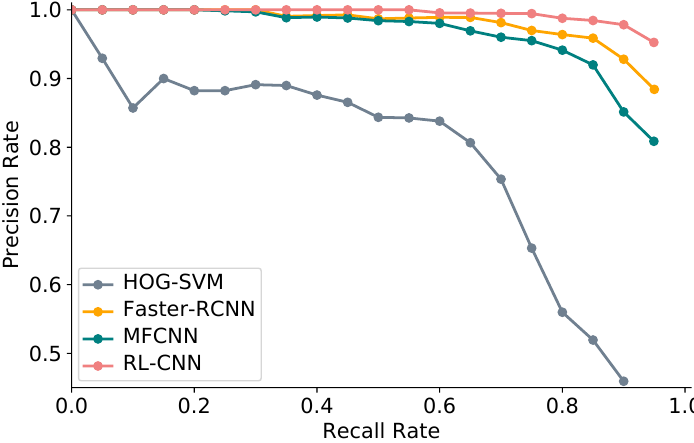
Figure 10. Precision–Recall Curves of HOG-SVM, MFCNN [6], Faster-RCNN [1] and our RL-CNN aircraft detection model. Our RL-CNN framework achieves the best performance.